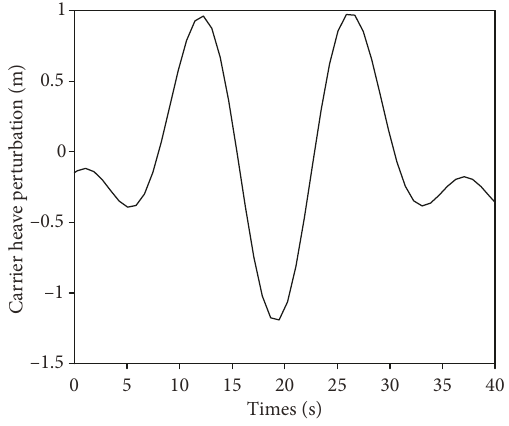
Figure 8: Deck motion under sea state 4.